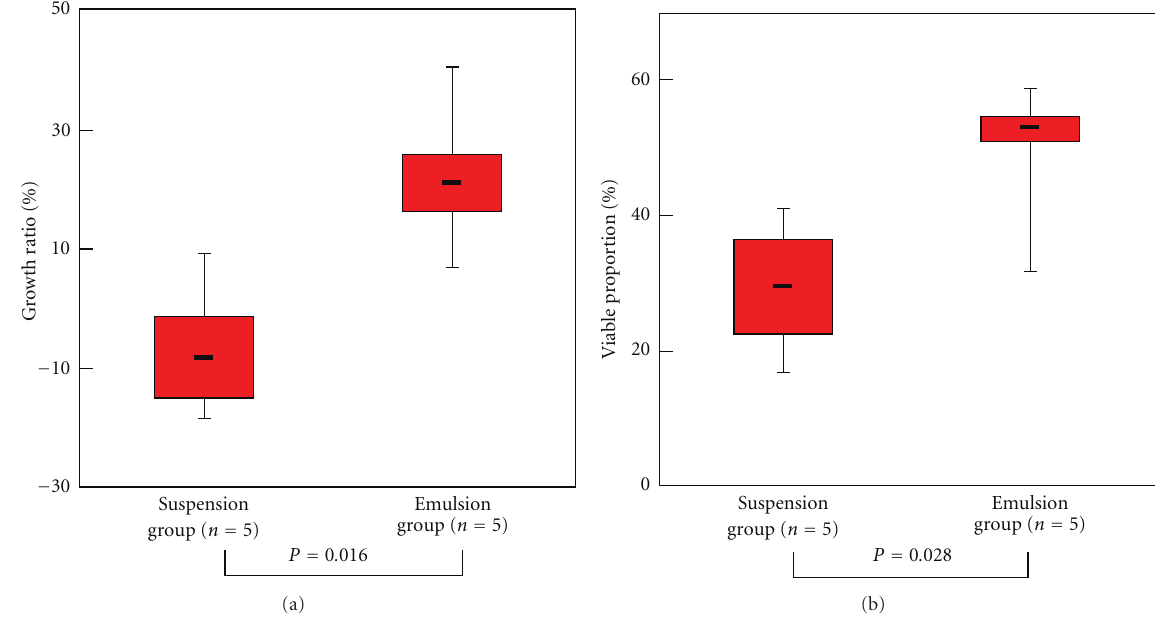
Figure 4: Growth ratio and viable proportion. (a) Graph showing the macroscopically determined growth ratio of liver tumors 7 days after TACE. The tumors in the suspension group showed minimal growth or slight shrinkage over the experimental period, while those in the emulsion group exhibited a mild increase in volume. The growth ratio of the tumors in the suspension group was found to be significantly smaller than that in the emulsion group ( P = 0 . 016, Mann-Whitney U test). (b) Graph showing the viable proportion of liver tumors at 7 days after TACE. The percentage of residual viable tumor cells ranged from 16.6% to 41.1% in the suspension group and from 31.6% to 58.7% in the emulsion group. The proportion of viable tumor cells was found to be significantly smaller in the suspension group than in the emulsion group ( P = 0 . 028, Mann-Whitney U